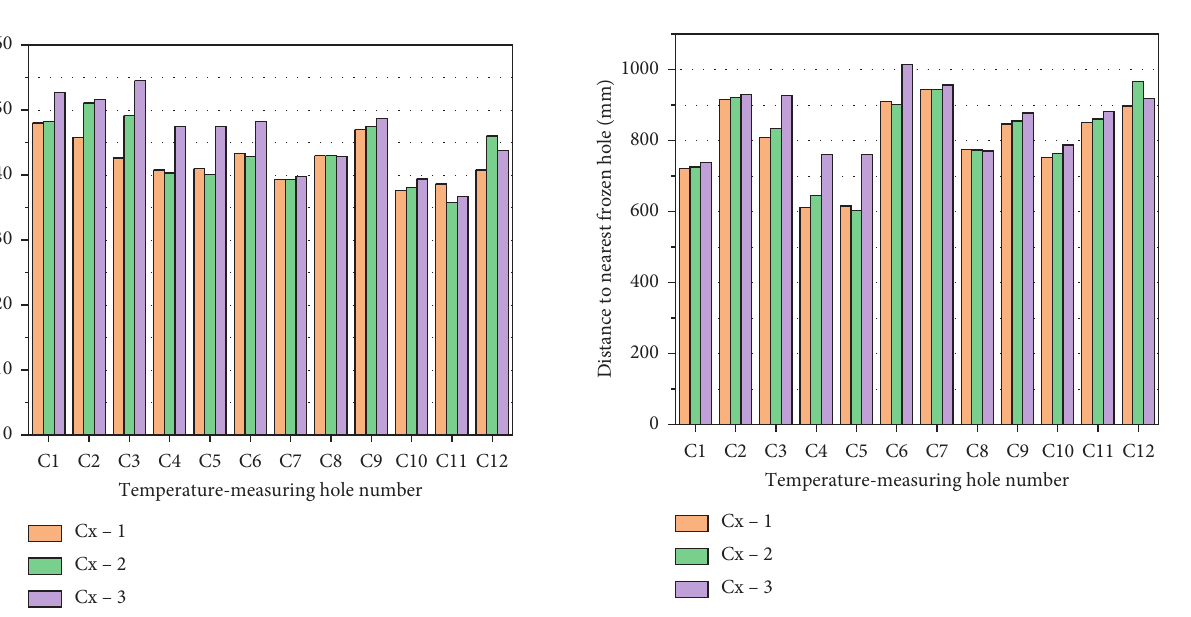
Figure 9: Freezing development rate of each measuring point.